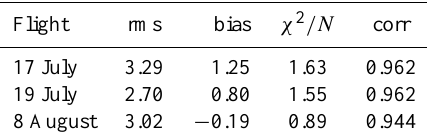
Table 1. Statistics on the comparison of the Cloud Radar System and CoSSIR retrieved vertically integrated 94GHz backscattering. The four statistics are the rms difference (dB), the bias or mean difference (dB), the reduced χ 2 using the retrieved error bars, and the linear